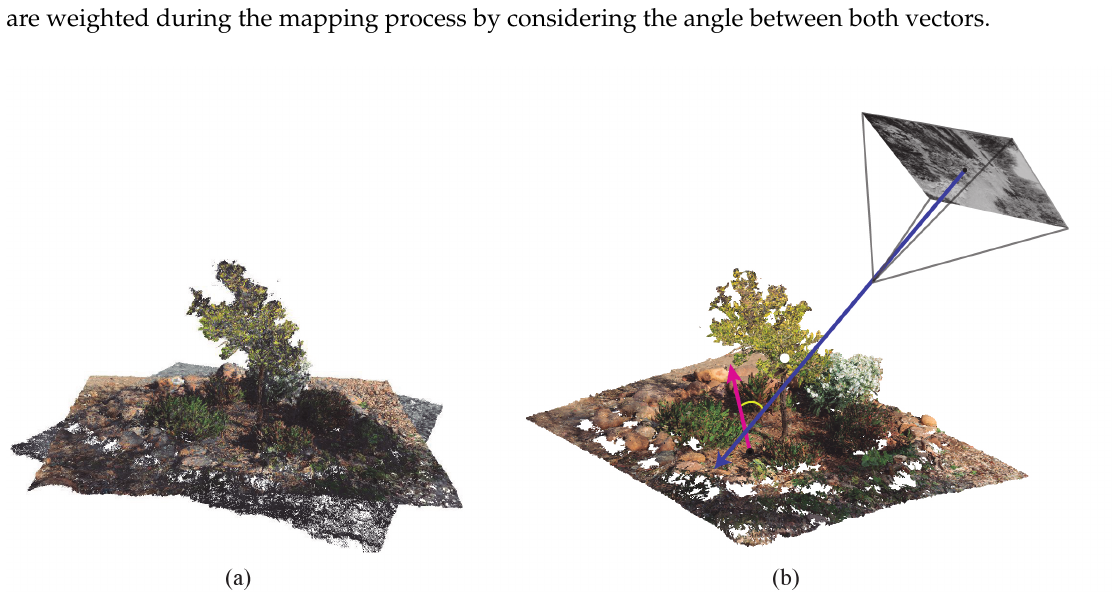
Figure 4. Data Fusion: ( a ) the point cloud alignment; and ( b ) multispectral image mapping on the point